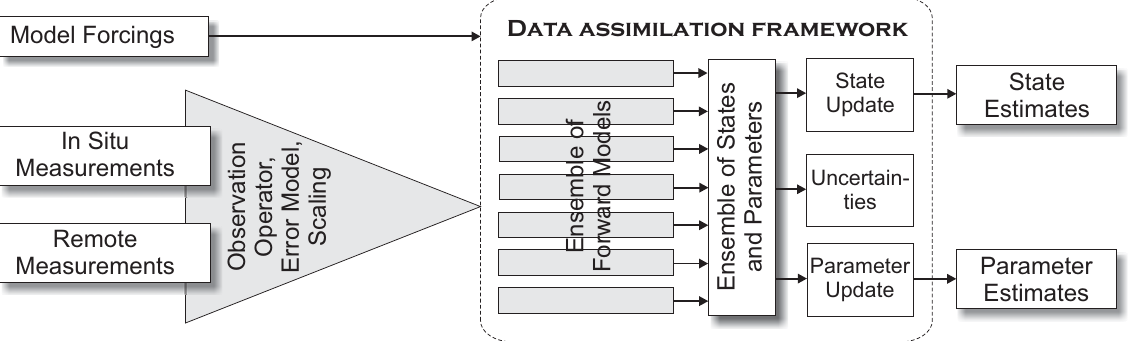
Figure 1. Ensemble-based DA system. Measurements are integrated into a DA framework by an observation operator for comparison with ensemble states for state (and parameter) updates. The scheme is presented for one time step only, the sequential character of DA is generated by new model forcings and new measurements initiating a new ensemble of forward models for the next time